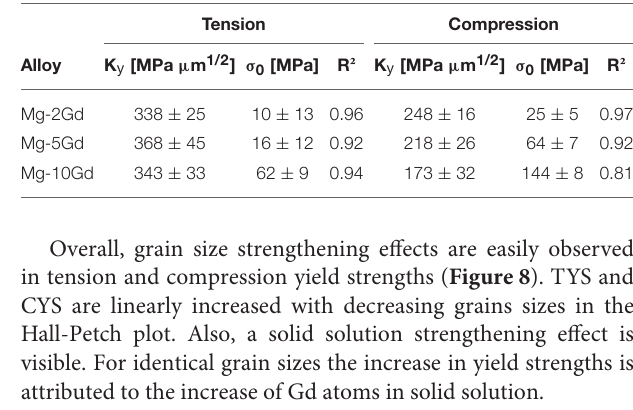
TABLE 2 | Hall-Petch coefficients for tension and compression including standard deviations (Harmuth et al., 2018).